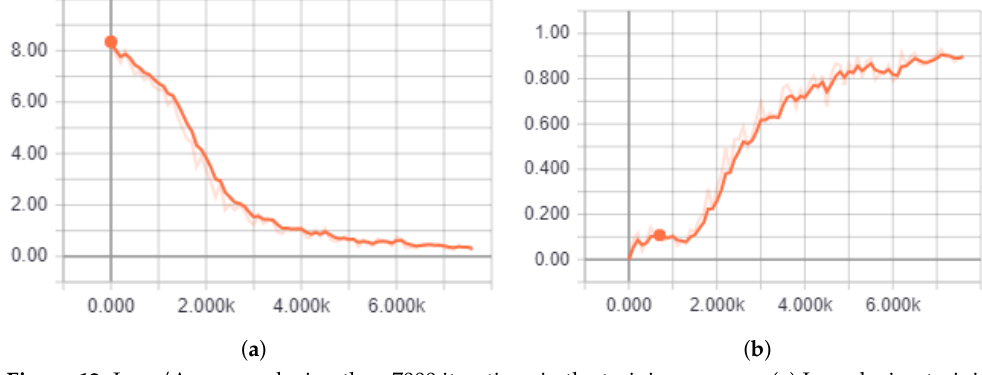
Figure 12. Loss/Accuracy during the >7000 iterations in the training process. ( a ) Loss during training. ( b ) Accuracy during the